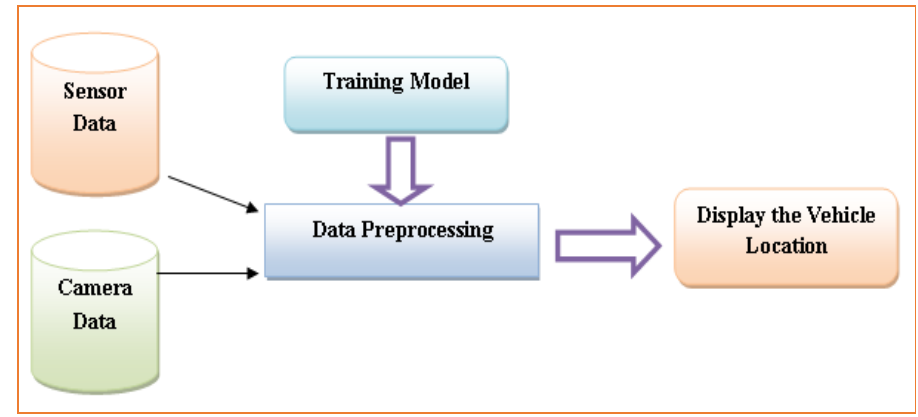
Figure 4. Vehicle Location Tracking in ITM.